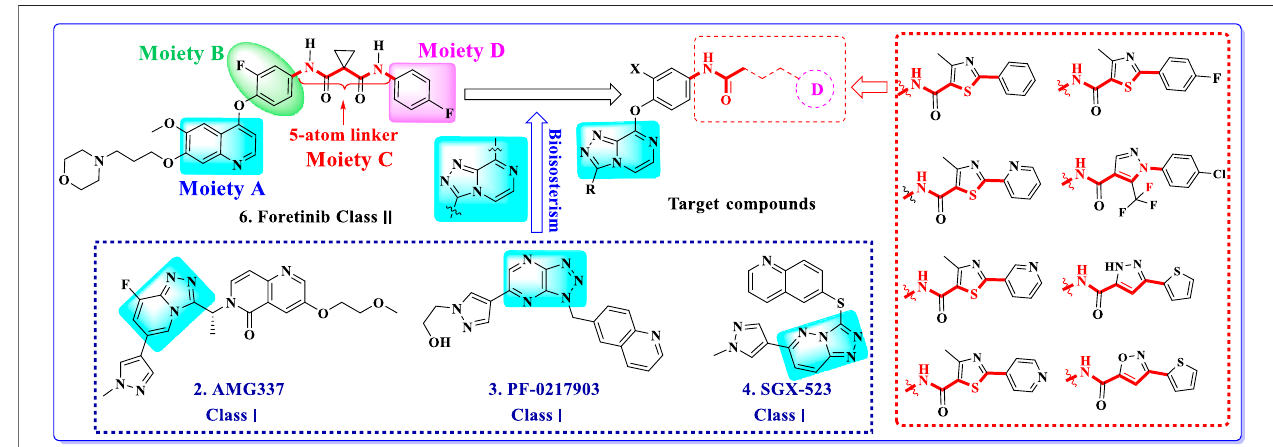
FIGURE 2 | Design strategy and structures of target